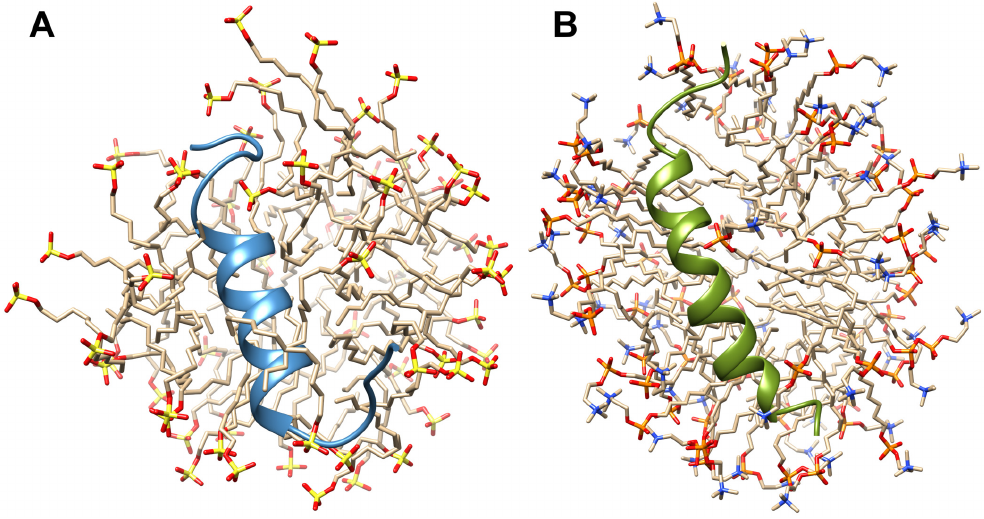
Figure 2. High-resolution 3D structures of TM4 segment (Pro252–Ser276) evaluated on the basis of acquired nuclear magnetic resonance (NMR) data and molecular dynamics simulations in SDS- d 25 ( A ) and DPC- d 38 ( B )